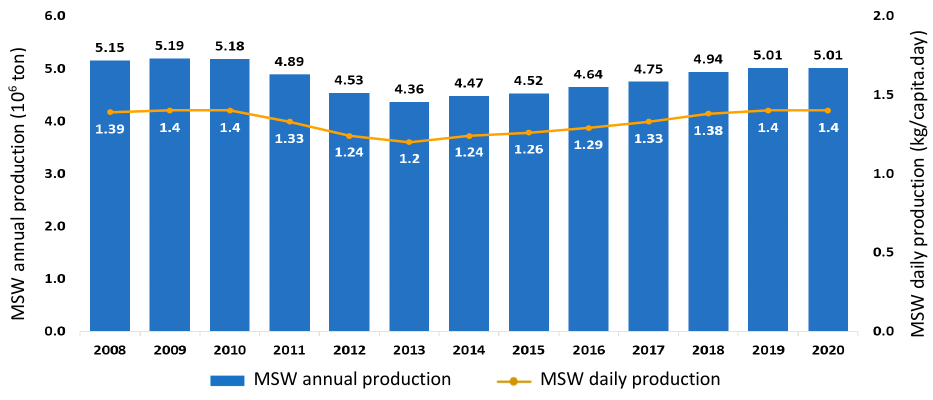
Figure 4. Production and capitation of municipal solid waste in mainland Portugal [43].